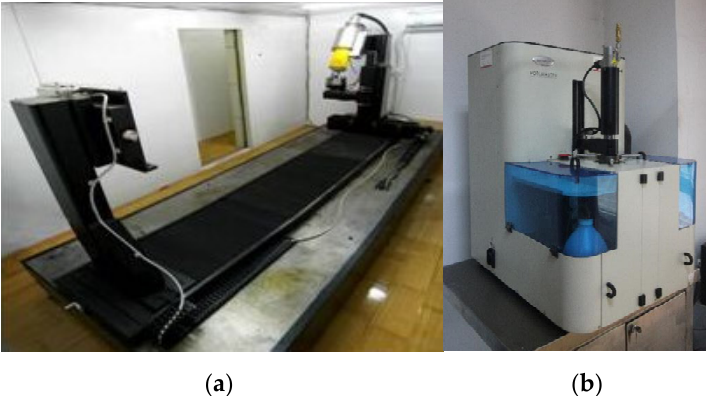
Figure 2. Experimental equipment: ( a ) X-ray Micro-Tomography system (model: µ CT225kVFCB) from Taiyuan University of Technology; ( b ) Quantachrome 33 from Quantachrome Instruments.